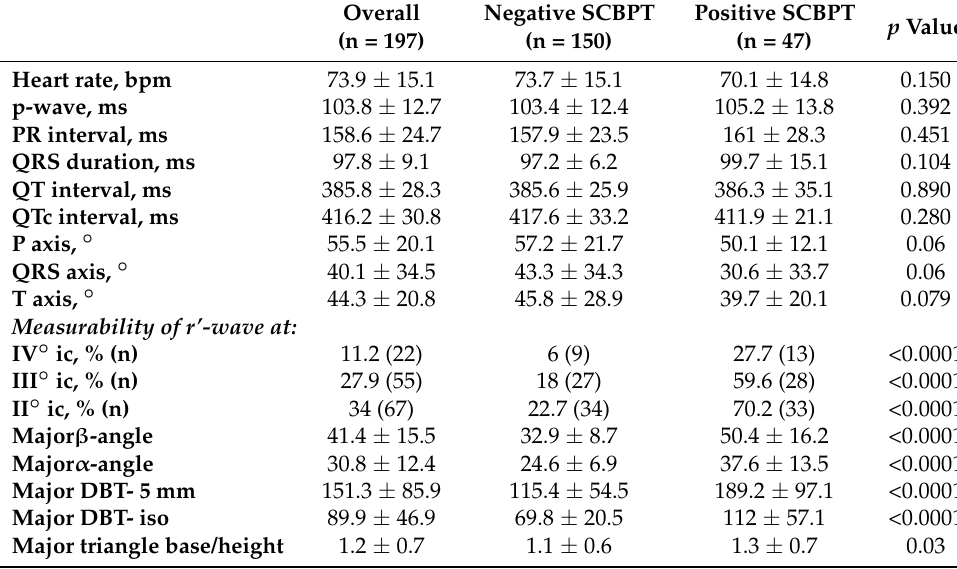
Table 5. Comparison of ECG characteristics and criteria of the validation cohort based on Brugada syndrome diagnosis after Sodium Channel Blocker Provocation